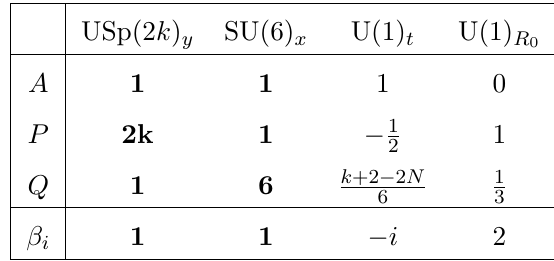
Figure 13 . Schematic representation of the 4 d rank stabilization duality. We don’t draw singlets, which are specified in the main text.